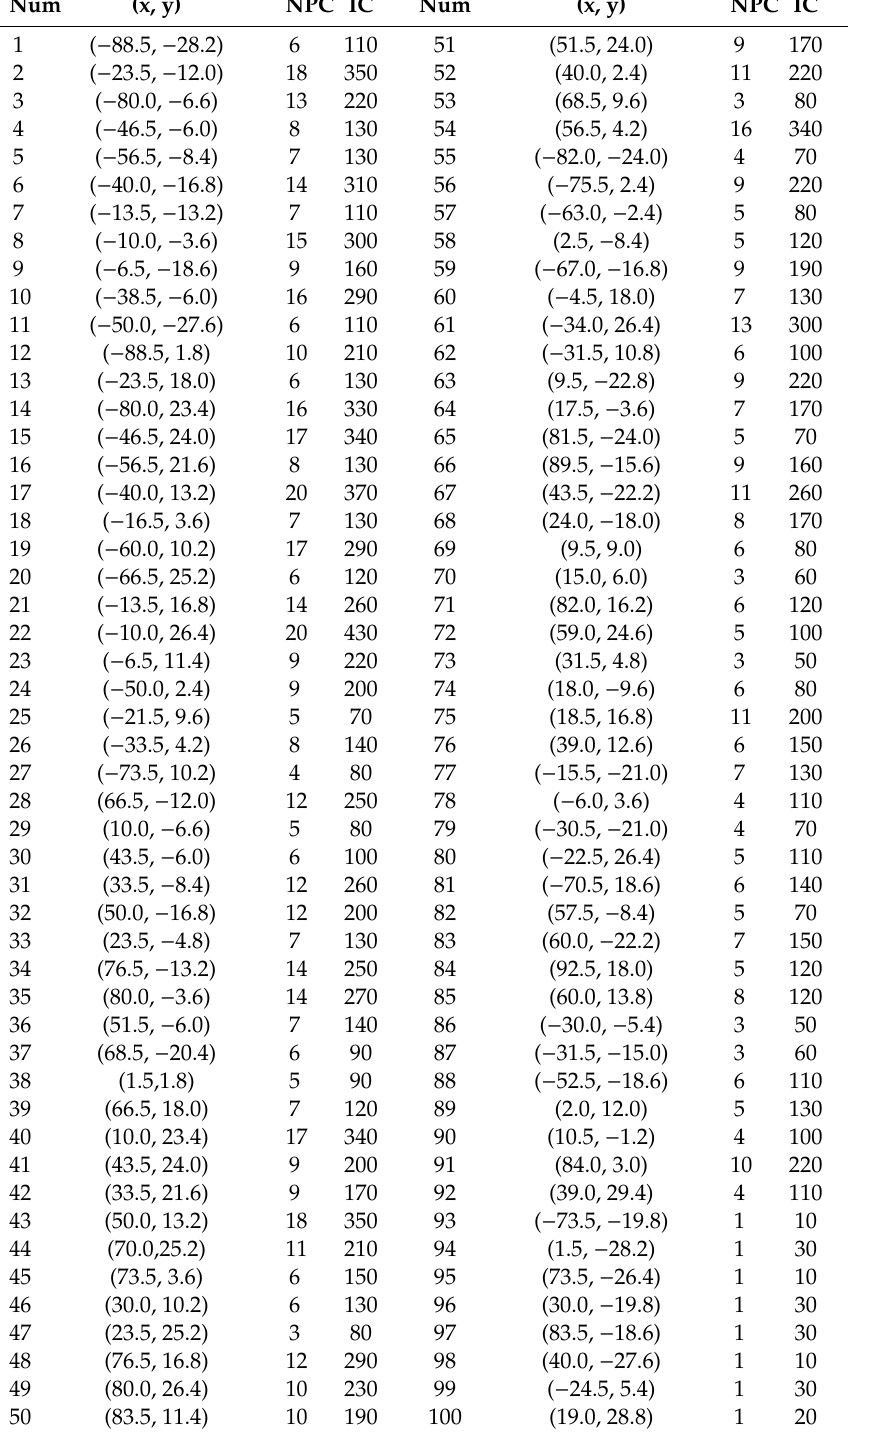
Table 1. Information after clustering of space